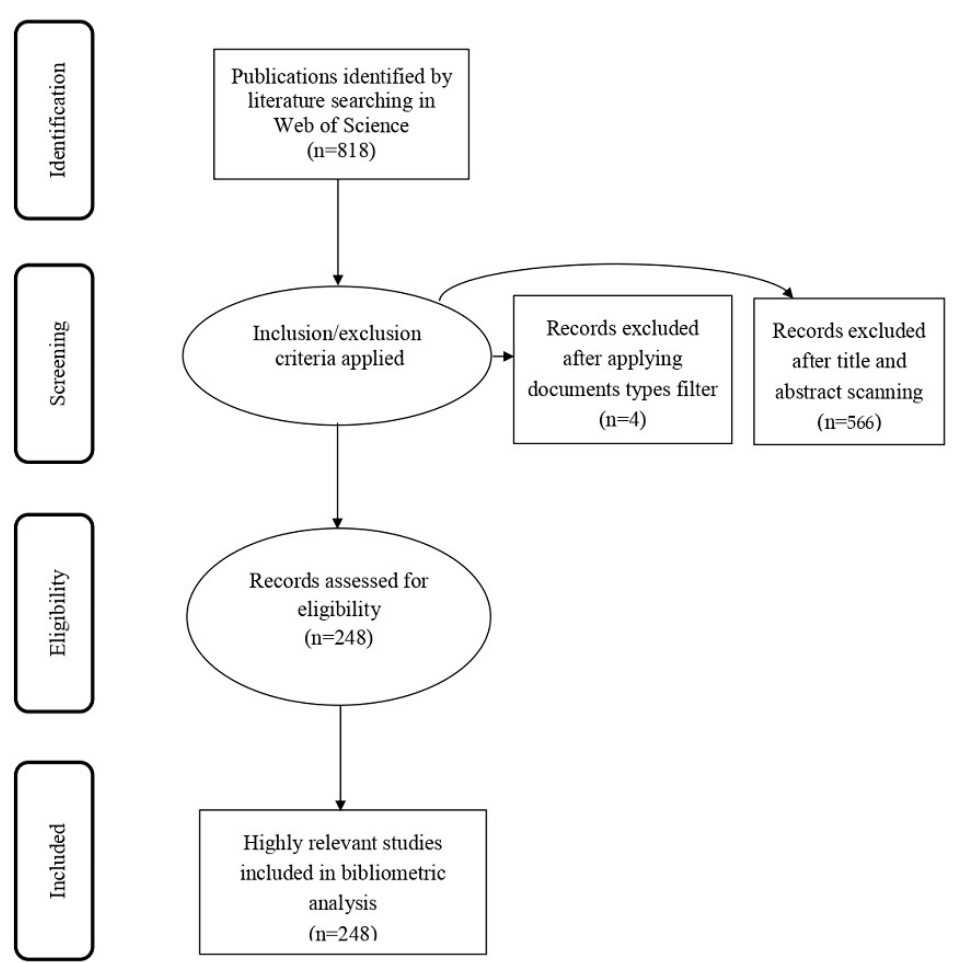
Figure 1. Four-phase flow diagram of data extraction and filtration process of dental adhesive publications.